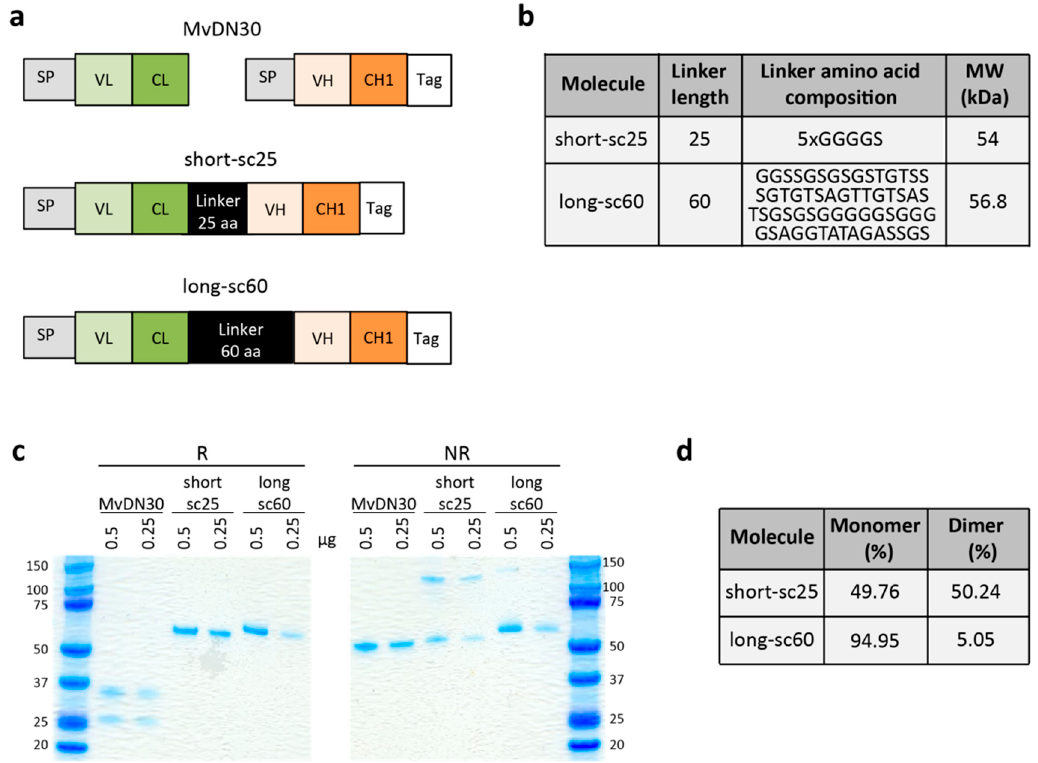
Figure 1. Schematic representation and analysis of single-chain Fabs. ( a ) Schematic representation of the parental MvDN30 and derived antibodies in single-chain format (short-sc25 and long-sc60). SP: signal peptide; VL: variable light domain derived from DN30; CL: constant light domain derived from human IgK light chain; VH: variable heavy domain derived from DN30; CH1: first constant heavy domain derived from human IgG1 heavy chain; Tag: strep and his tag sequences. ( b ) Table showing the amino acid sequences of the linkers included in the single-chain Fabs. The molecular weight (MW) of the two different single-chain antibodies calculated on the basis of their amino acid sequences (including the linker) is reported. ( c ) SDS-PAGE of the purified DN30 derivatives in reducing (R) and non-reducing (NR) conditions. ( d ) Table showing the percentage of the monomer and dimer forms of each single-chain antibody calculated by quantification of the SDS-PAGE bands.